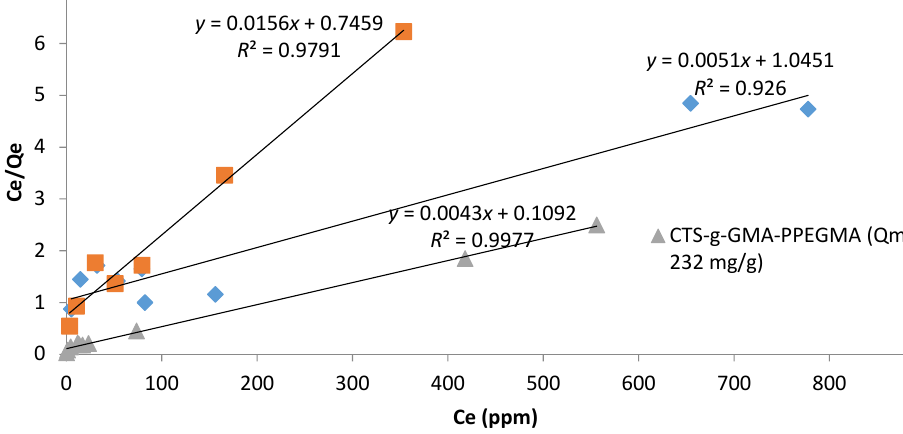
Figure 10. Linearized Langmuir isotherm.